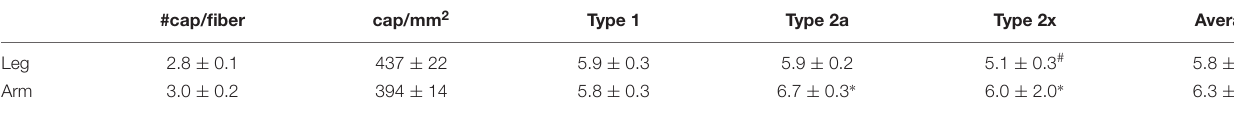
FIGURE 2 | The relationships between the percentage of MHC-1 and 3-hydroxyacyl-CoA dehydrogenase activity (HAD, n = 10) (A) ; citrate synthase activity (CS, n = 9) (B) ; and relative capacity to oxidize fat (HAD/CS ratio) (C) . The open circles depict data for the arms and the leg black squares for the legs. For the arm and leg combined, there was a significant correlation between the MHC-1 content and HAD activity ( r 2 = 0.32, P = 0.011), as well as the HAD/CS ratio ( r 2 = 0.27, P = 0.021). TABLE 3 | Capillary density in the arm ( triceps brachii ) and leg ( vastus lateralis ) muscles of elite cross-country skiers ( n = 10).